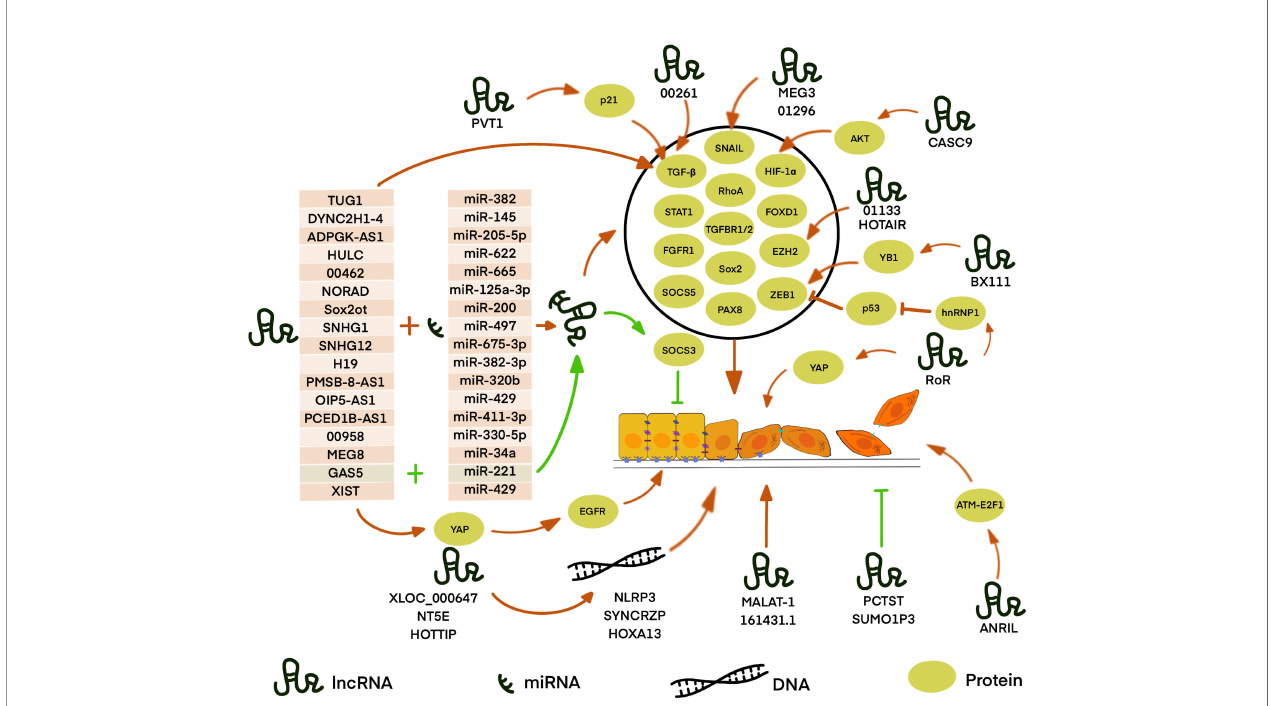
FIGURE 2 | LncRNA is involved in EMT in PDAC through different pathways. Most known LncRNA can act as competing endogenous RNAs (ceRNA) to sequester target miRNA away from mRNA or DNA thus regulating the expression of downstream proteins. LncRNAs, such as XLOC_000647, NE5T, and HOTTIP, can regulate gene expression by binding with local chromatin architectures which localize physically nearby. LncRNAs,such as RoR, BX111, LINC01133, and CASC9, can directly regulate or interact with EMT-related proteins or further affect the expression of its downstream targets. However, some lncRNAs, such as MALAT-1, TUG1, LINC00261, PVT I, ANRIL, MEG3, HOTAIR, SUMO1P3, and LINC01296, play an important role in the EMT process with unclear mechanisms. Red arrows: the pathway promotes EMT, green arrows: the pathway inhibits EMT, the black circle: the proteins regulated by ceRNA and positively regulates